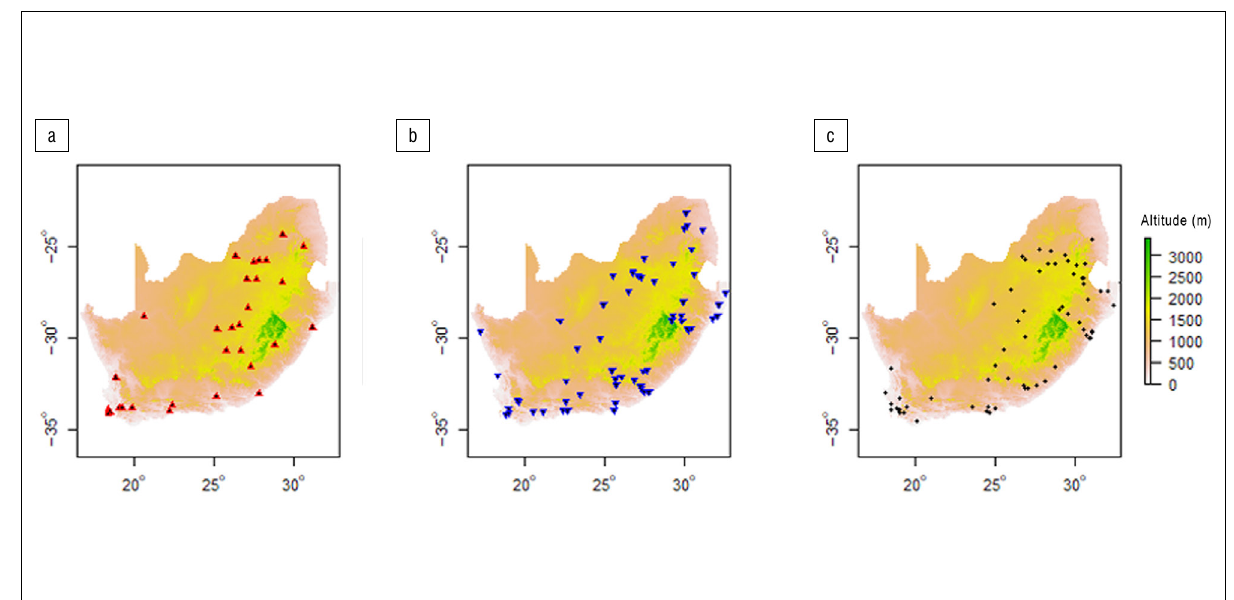
Figure 3: The spatial distribution of pan evaporation trends across South Africa, showing stations with (a) increasing, (b) decreasing, and (c) no